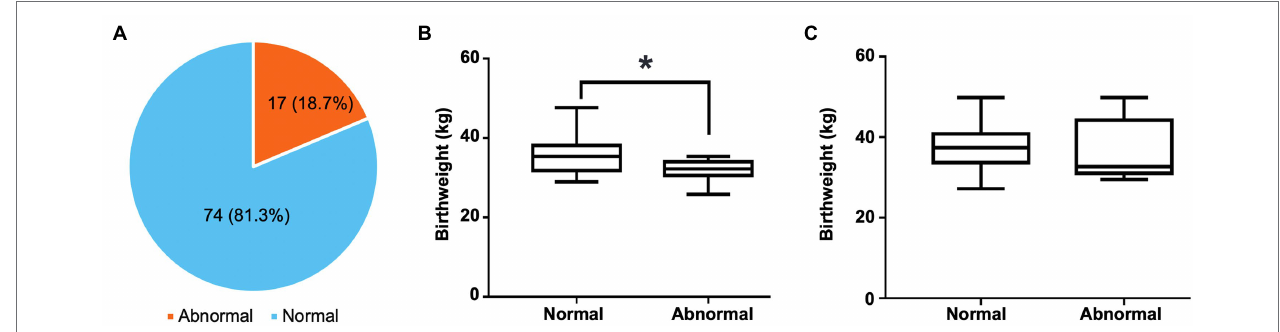
FIGURE 1 | The distribution of normal and abnormal feces and its relationship with birthweight of preweaning calves. (A) The prevalence of normal and abnormal feces of preweaning calves. (B) The difference in birthweight between heifers with normal feces and those with abnormal feces. (C) The difference in birthweight between bulls with normal feces and those with abnormal feces. In the box plot, the asterisk reflects that they are significantly different ( p < 0.05) based on the Student’s t -test.